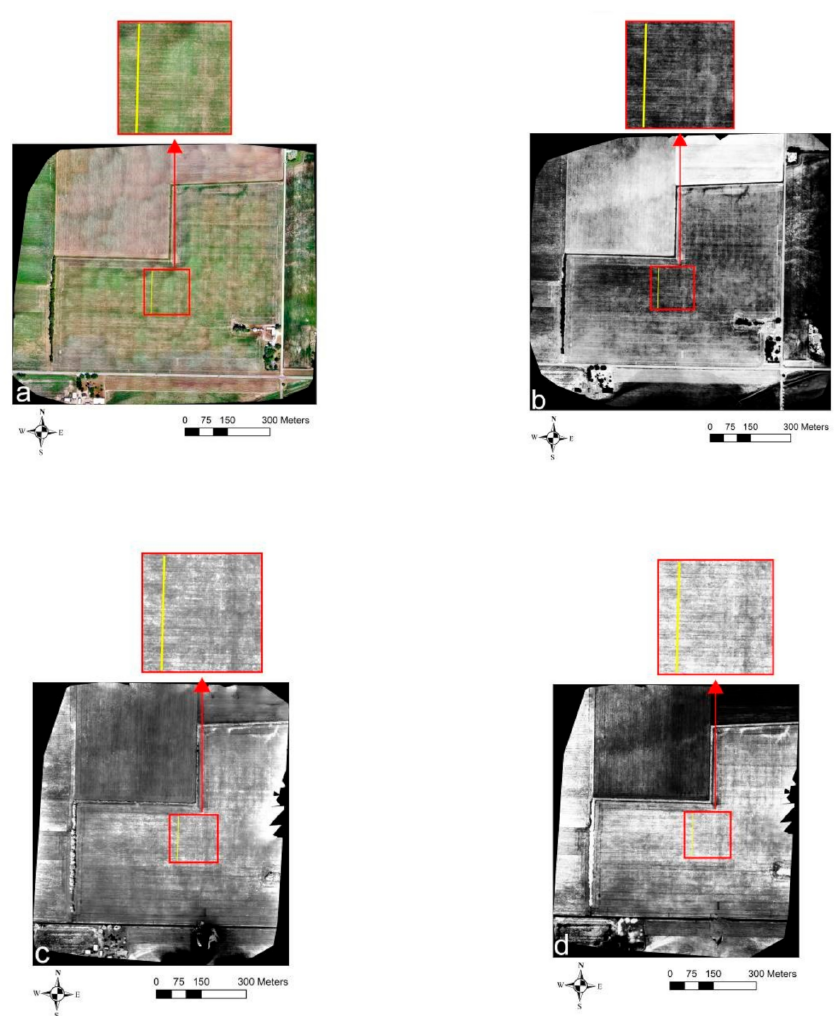
Figure 8. Site-3 UAV survey results from 12 July 2018: ( a ) VIS-C, ( b ) TIR, ( c ) NIR, and ( d ) NDVI orthomosaic imagery. Solid yellow lines indicate the drain lines’ directional trend.